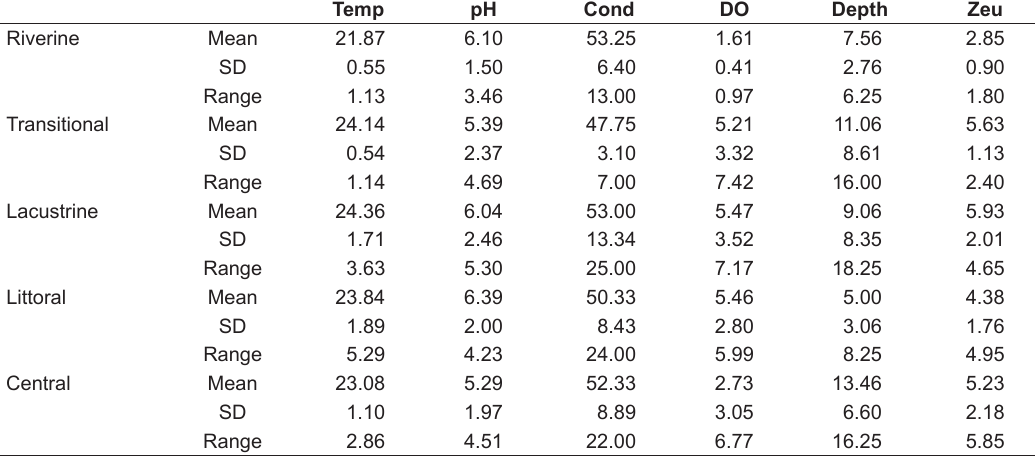
Table 3. Summary of water variables values recorded in situ - mean, range and standard deviation (SD) - in the Itupararanga Reservoir, High Sorocaba Basin, SP, Brazil: during wet season (December, 2009 and February, 2010) measure for riverine, transitional and lacustrine zones as well for littoral and central regions. Temp.= temperature (°C), Cond = electric condutance (µS.cm –1 ), DO = dissolved oxygen (mg.L –1 ), Depth, Zeu = euphotic zone (m).